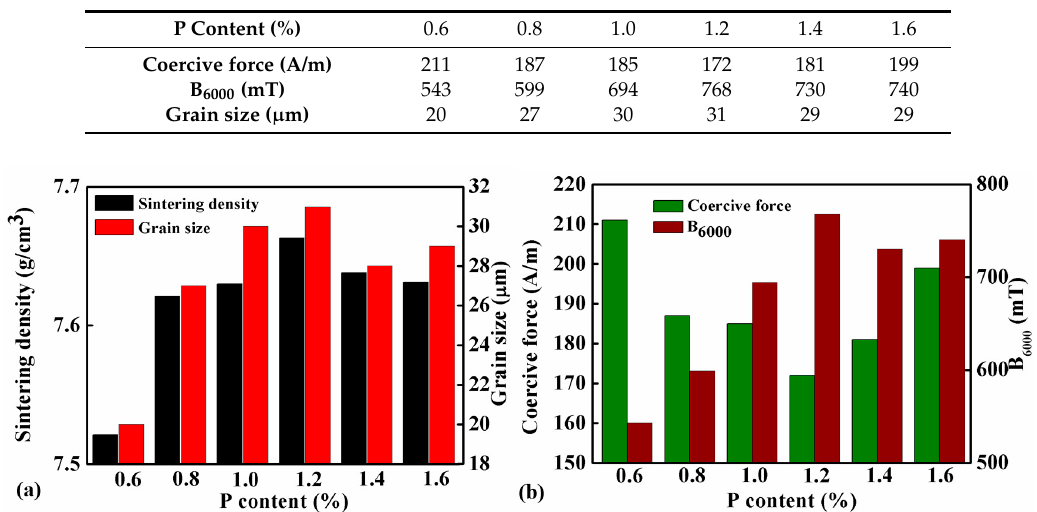
Table 3. A summary of coercive forces, magnetic induction, and grain size of Fe-x P (x = 0, 0.6, 0.8, 1.0,